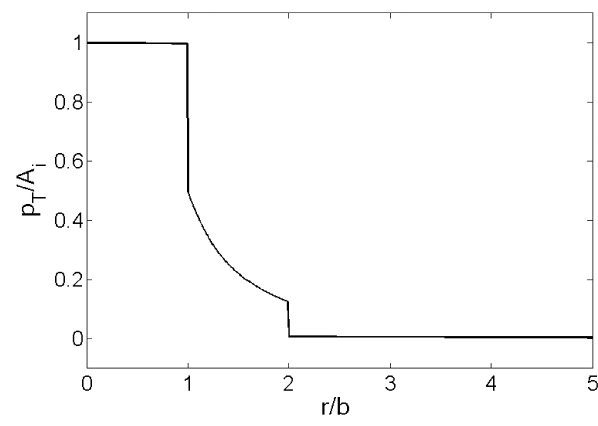
Figure 3. The radial distribution of the radial component of the plasma displacement for the principal sausage mode. Here a = 2 b .